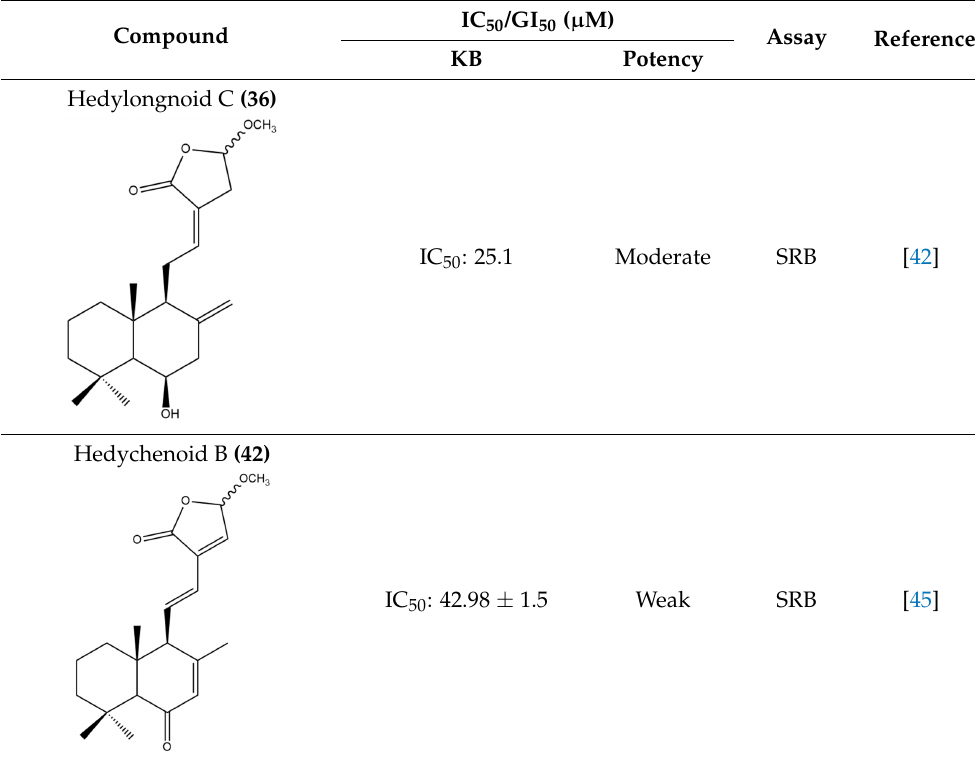
Table 10. Cytotoxic activities of labdane-type diterpenes from the Zingiberaceae against HeLa cervical cancer cell line.